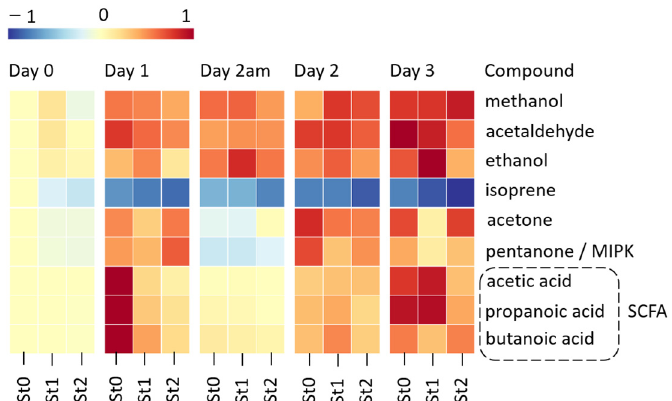
Figure 4. Relative change in the median concentrations of the significant VOCs in relation to the effect of exercise during the 4 days. The concentrations are relative to baseline measurements of before walking of non-statin users (St0) and range scaled by row. All the VOCs, including the short-chain fatty acids (SCFA), reflect a recovery type effect for all participants, by increasing following Day 1 of exercise and then subsequently decreasing after a rest period (Day 2 am), and increasing again after exercise (Day 2, Day 3). Isoprene is an exception, and it shows the opposite trend, i.e., decreasing in relation to